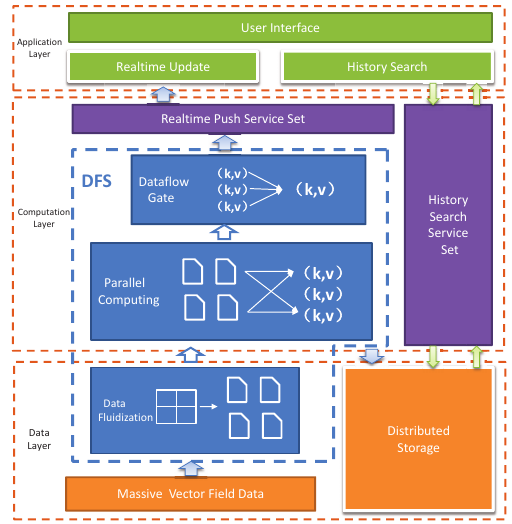
Figure 3. Overview of data process